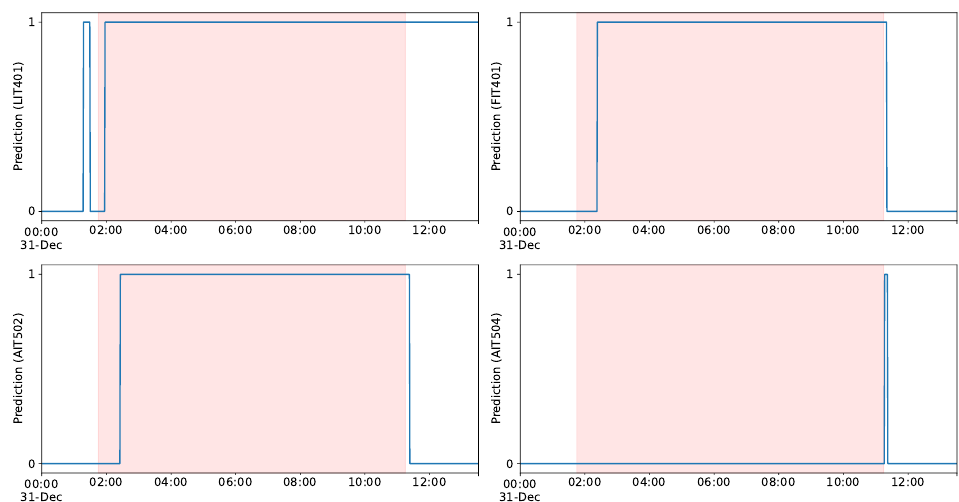
Figure 10. Detection of Attack 18 in SWaT testbed using four univariate models (LIT401, FIT401, AIT502, AIT504) with the proposed approach. Red region denote the ranges of the injected